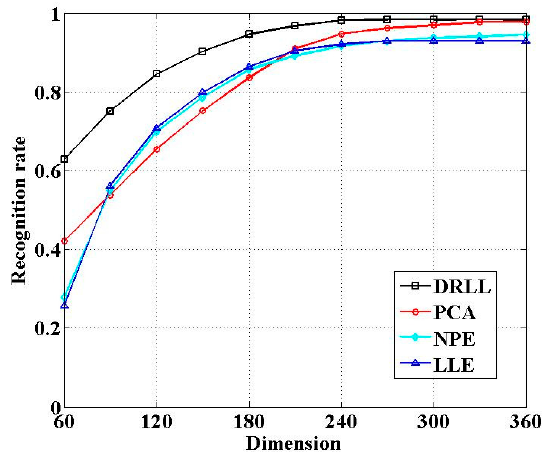
Figure 12. Comparison of four algorithms under varying dimensions of samples.